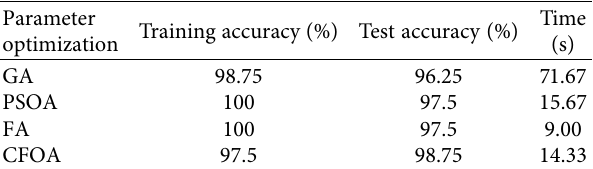
Figure 9: Fault classification results of bearing with different damage degree. Table 2: Diagnostic results of different feature extraction methods. Table 3: Training and testing results of different parameter opti- mization Feature extraction